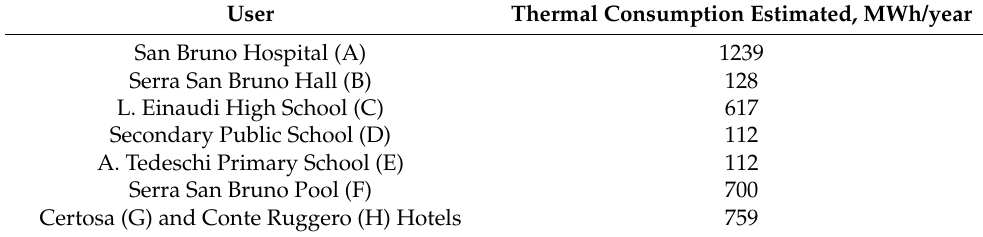
Table 3. Thermal consumption estimated for the large users.